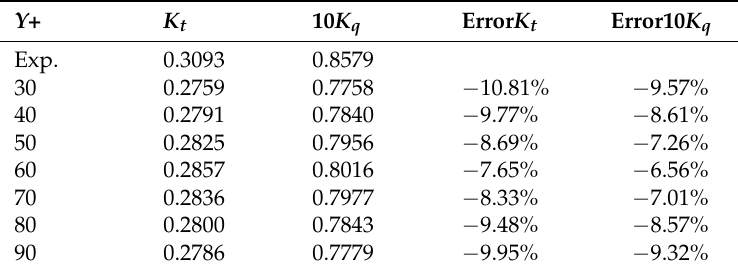
Table 2. Results for the Y+ for selection.